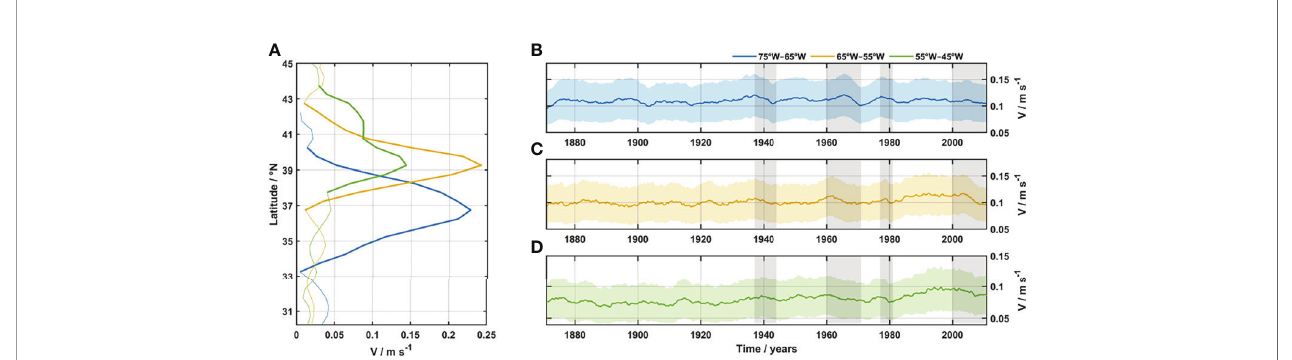
FIGURE 3 | The Gulf Stream. (A) Meridional pro fi les of the absolute velocity averaged in the upper 1000 m for each sub-region along the Gulf Stream: western (75° W – 65°W, blue line), central (65°W – 55°W, yellow line), and eastern/extension (55°W – 45°W, green line) zones. The Gulf Stream cores are marked with a thicker line for each region. (B) Averaged monthly time-series of absolute velocity at the western Gulf Stream, (C) central Gulf Stream region, and (D) extension Gulf Stream region inside the core in the upper 1000 m between 1871 and 2010. Colored shadowed areas in (B – D) represent the standard deviation. Shadow grey areas mark the periods of velocity decrease of the Gulf Stream. Absolute velocity was calculated from the monthly zonal and meridional velocity fi elds from SODA-POP v2.2.4 (Carton and Giese, 2008; Giese and Ray, 2011). The time-series are smoothed with a 60-months running